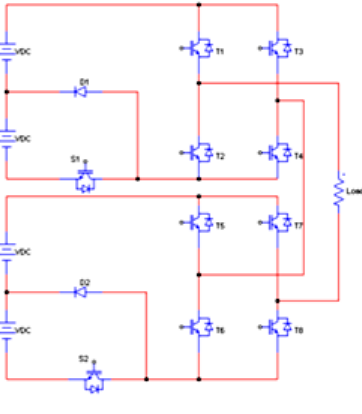
Figure 6. Cascaded MLI circuit.